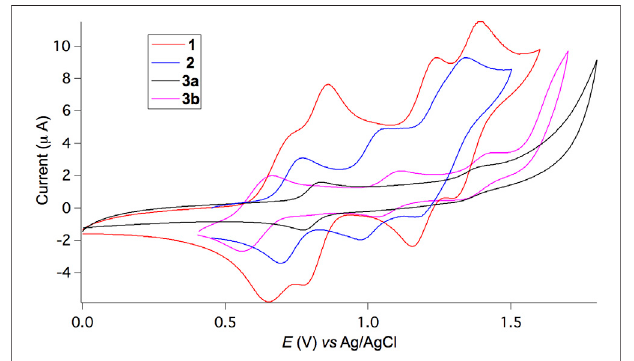
FIGURE 3 | Cyclic voltammograms versus Ag/AgCl of 1 , 2, and 3 in CH 2 Cl 2 and0.1 MBu 4 NPF 6 supportingelectrolyteatascanrateof100